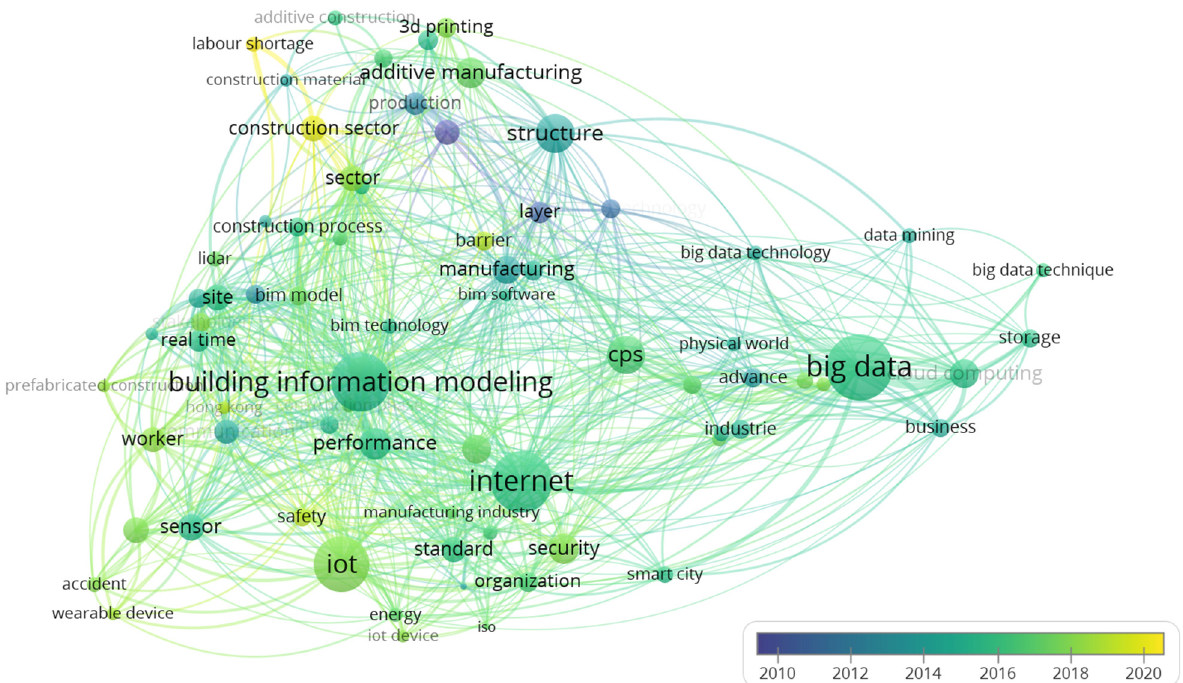
Figure 4. The main Construction 4.0 drivers.